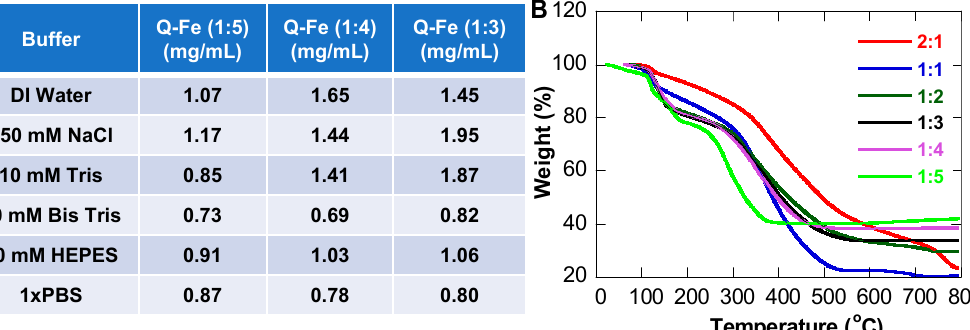
Figure 5. ( A ) Solubility of QFeNPs with Q-Fe ratios of 1:5, 1:4, and 1:3 in various solutions; and ( B ) TGA plots of QFeNPs powders with all Q-Fe ratios after freeze-drying.